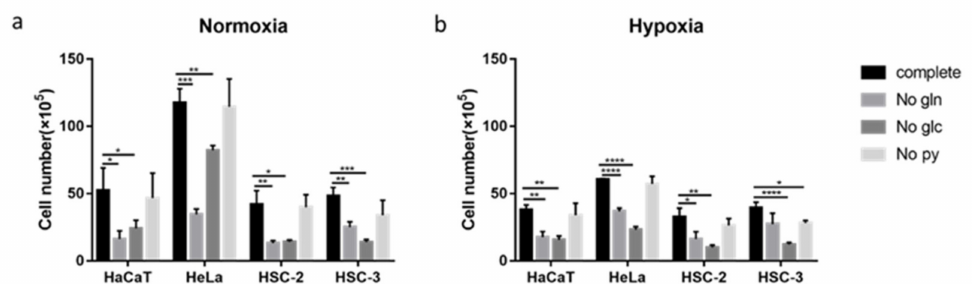
Figure 6. Effects of nutrient conditions on cell growth. ( a ) Effects of glucose, glutamine, and pyruvate on cell growth under normoxia. ( b ) Effects of glucose, glutamine, and pyruvate on cell growth under hypoxia. The Student’s t -test. * p < 0.05, ** p < 0.01, *** p < 0.001, **** p < 0.0001. All experiments were independently performed in triplicate. “Complete” means cells cultured in DMEM with all components, “No gln” means cells cultured in glutamine-free DMEM, “No glc” means cells cultured in glucose-free DMEM, and “No py” means cells cultured in pyruvate-free